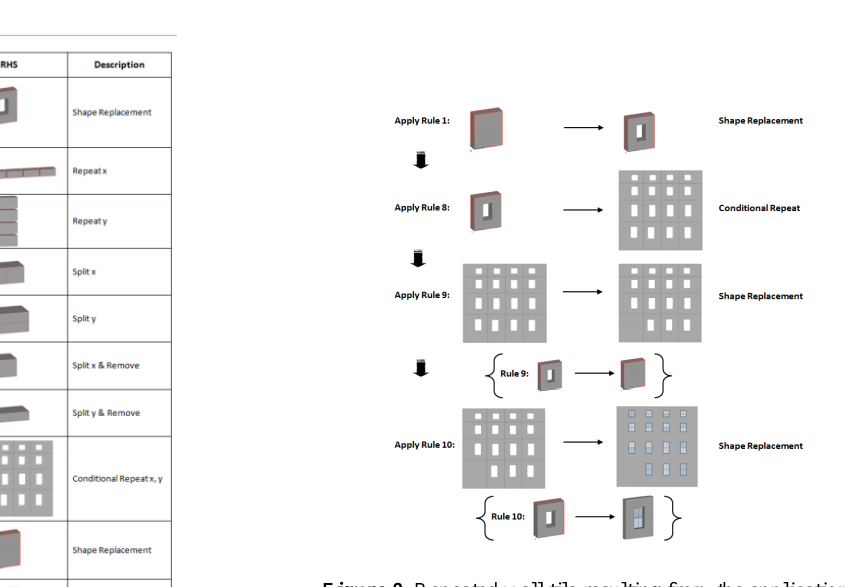
Figure 8. Repeated wall tile resulting from the application of Rule 8 to shape TW.